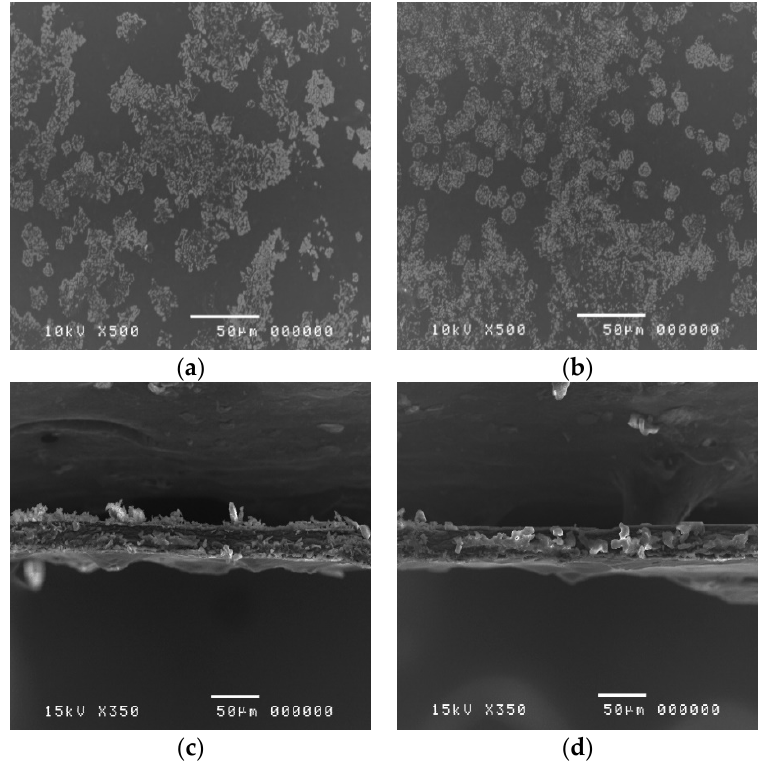
Figure 7. SEM micrographs of the surface and cross section of cLMPC and DPC films at 500 and 340 magnification. ( a ) surface of a cLMPC film; ( b ) surface of a DPC film; ( c ) cross ‐ sectional image of a cLMP film; ( d ) cross ‐ section image of a DPC film.